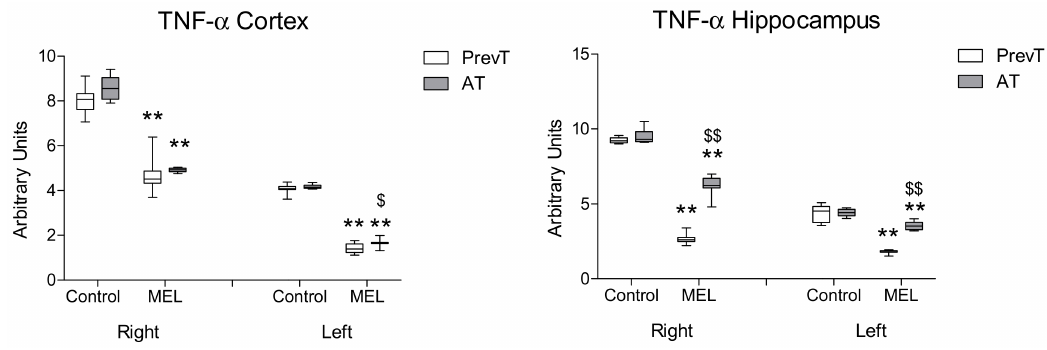
Figure 2. Right and left cortical and hippocampal mRNA expression of TNF- α in 18-month-old rats in control (non-treated) conditions, after treatment with a daily dose of melatonin (10 mg/kg b.w.) from 24 h before until 7 days after surgery (PrevT), and treated only after surgery during 7 days (AT). Each value represents the median, interquartile and full range of five determinations performed in duplicate. ** p < 0.01 with respect to the values obtained in the control group; $ p < 0.05 with respect to the values obtained in the PrevT group; $$ p < 0.01 with respect to the values obtained in the PrevT